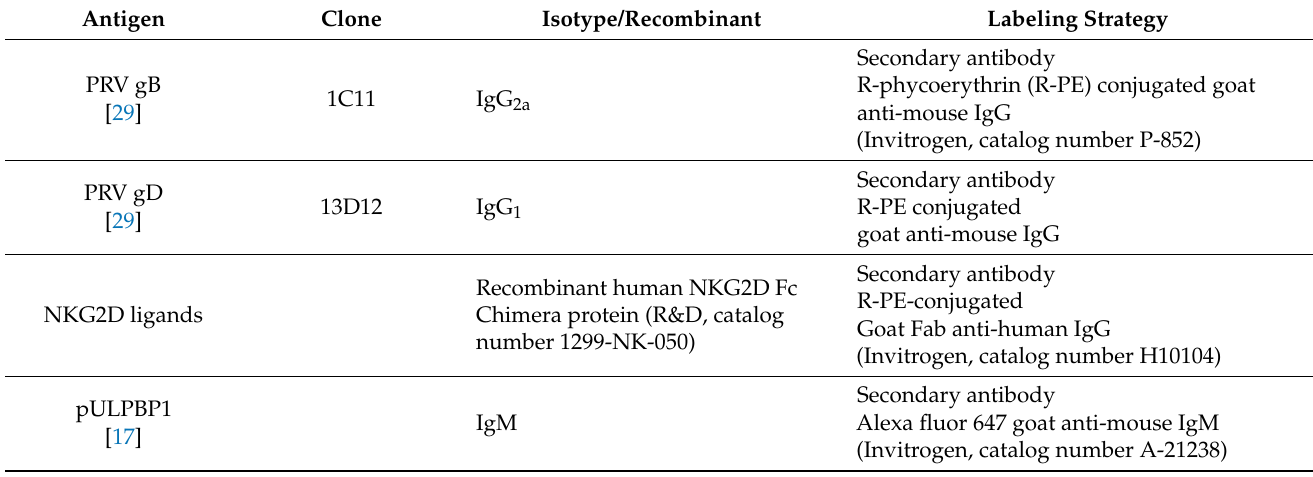
Table 1. Primary and secondary antibodies used for cell surface expression analysis by flow cytometry. Antigen Clone Isotype/Recombinant Labeling Strategy PRV